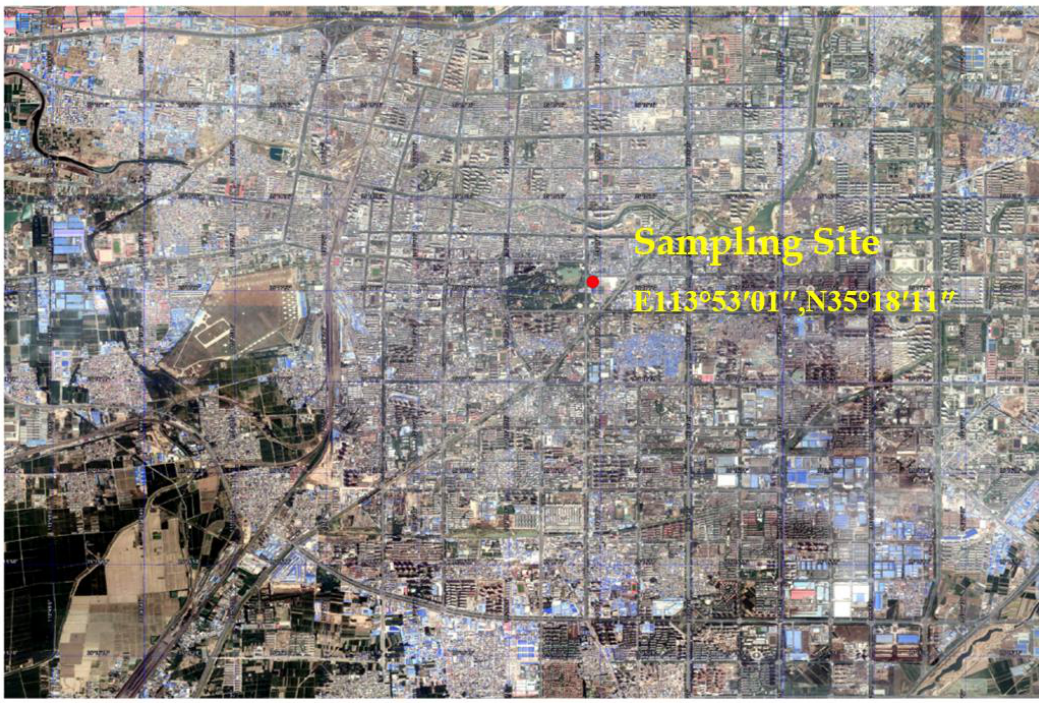
Figure 1. Location of the sampling site in Xinxiang, Henan, China.